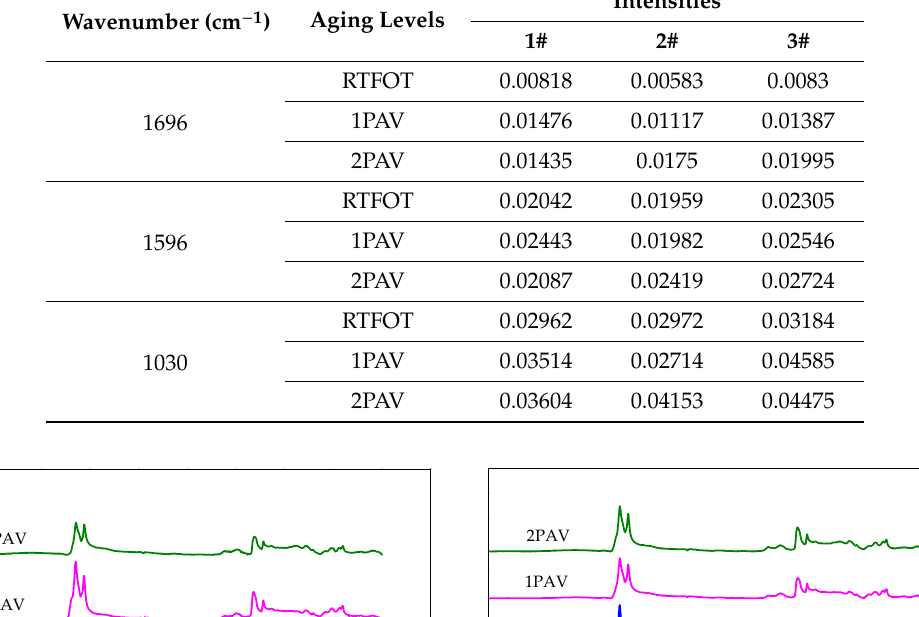
Table 7. Intensities of three absorption peaks. Table 6. Functional groups in asphalt rubbers [34–37].